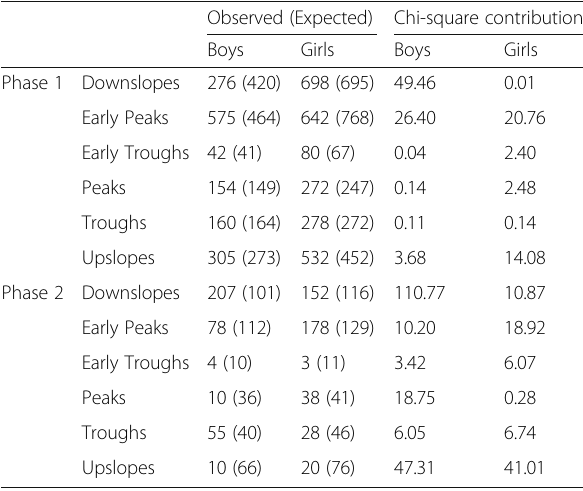
Table 2 The observed and expected frequencies of the six shape-based clusters representing the knee valgus moment Observed (Expected) Chi-square